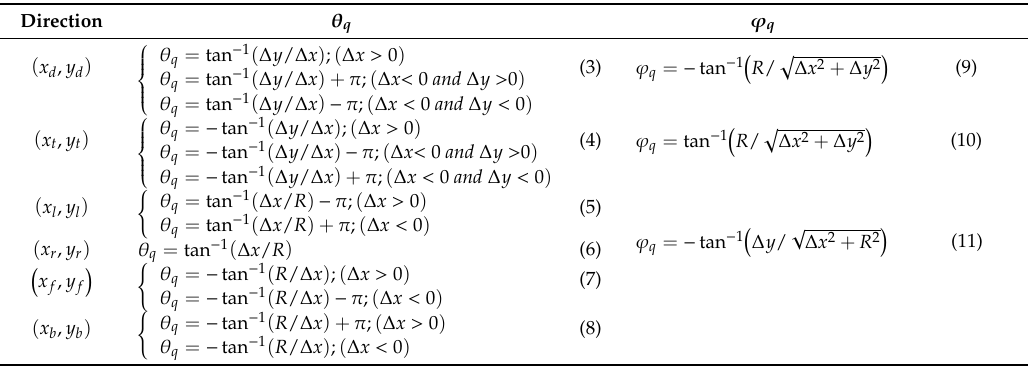
Table 1. Mapping equations of perspective images.